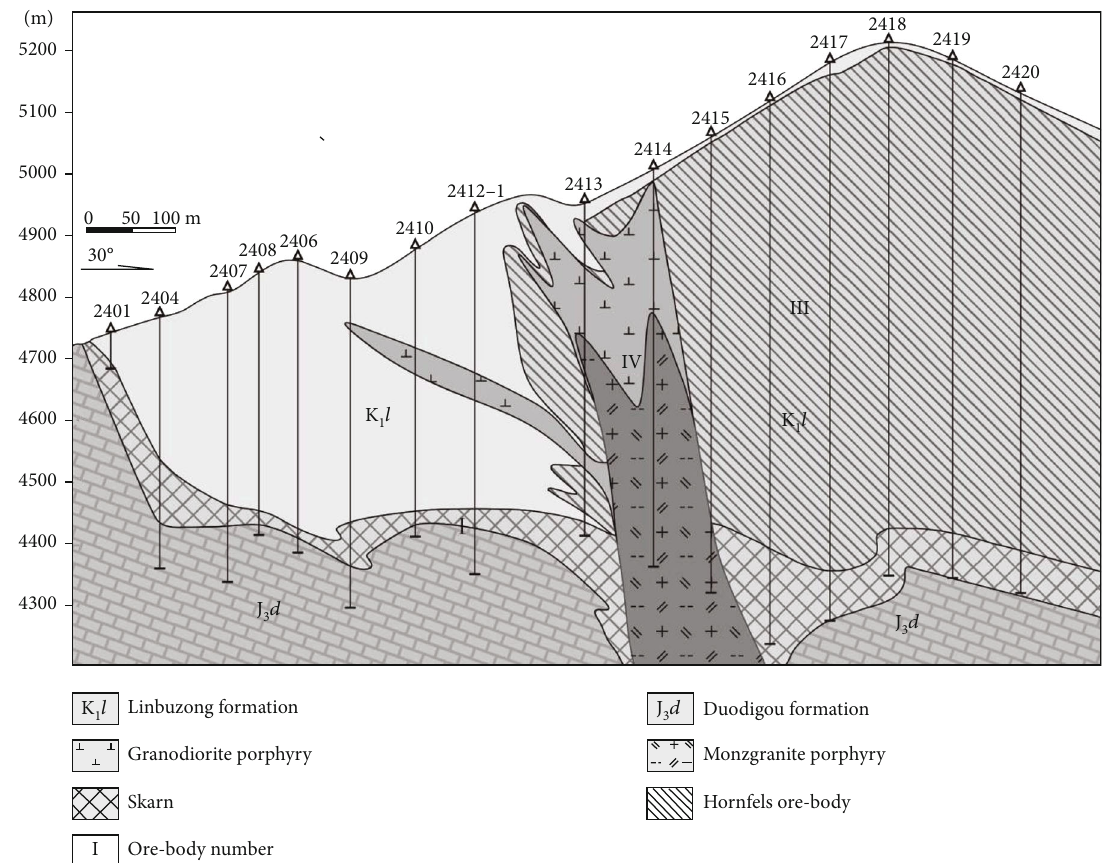
Figure 4: The #24 geological pro fi le of the Jiama deposit (modi fi ed from [23,